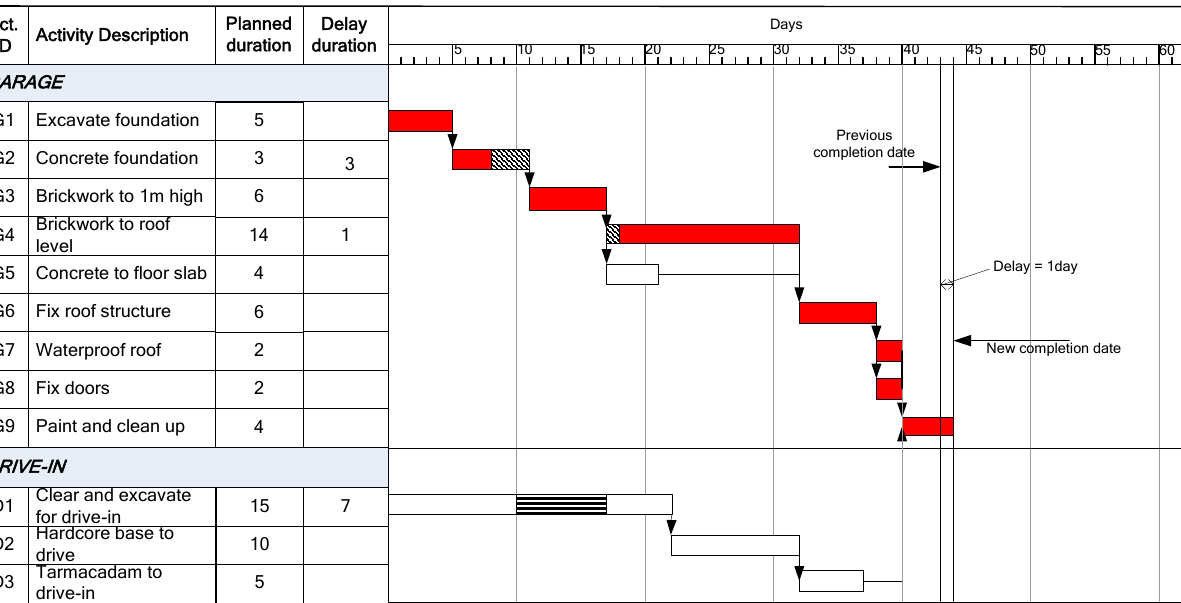
Figure 7. Impact of third delay.